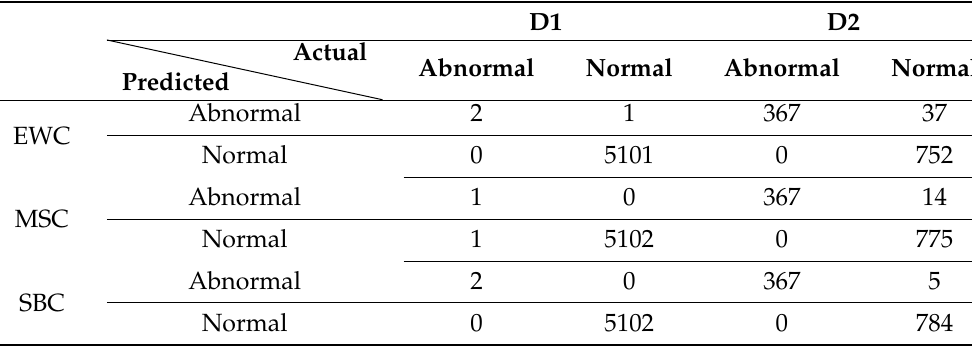
Table 1. Confusion matrix for all balancing criteria and both datasets. For each confusion matrix we have true negatives (true abnormal Wafer-ID detected) and false negative (normal wafer classified as abnormal) on the first row, while on the second row we have the false positive (abnormal wafer classified as normal) and true positive (true normal